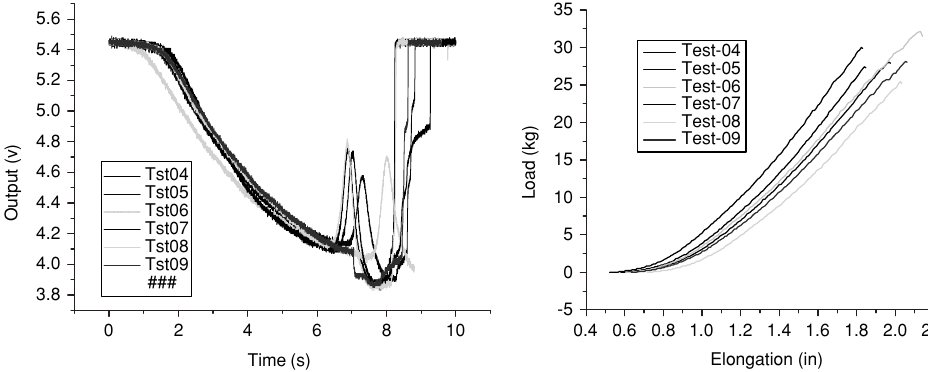
Figure 11 Optical sensors output (left) and the tensile tester outputs (right) for the six tested